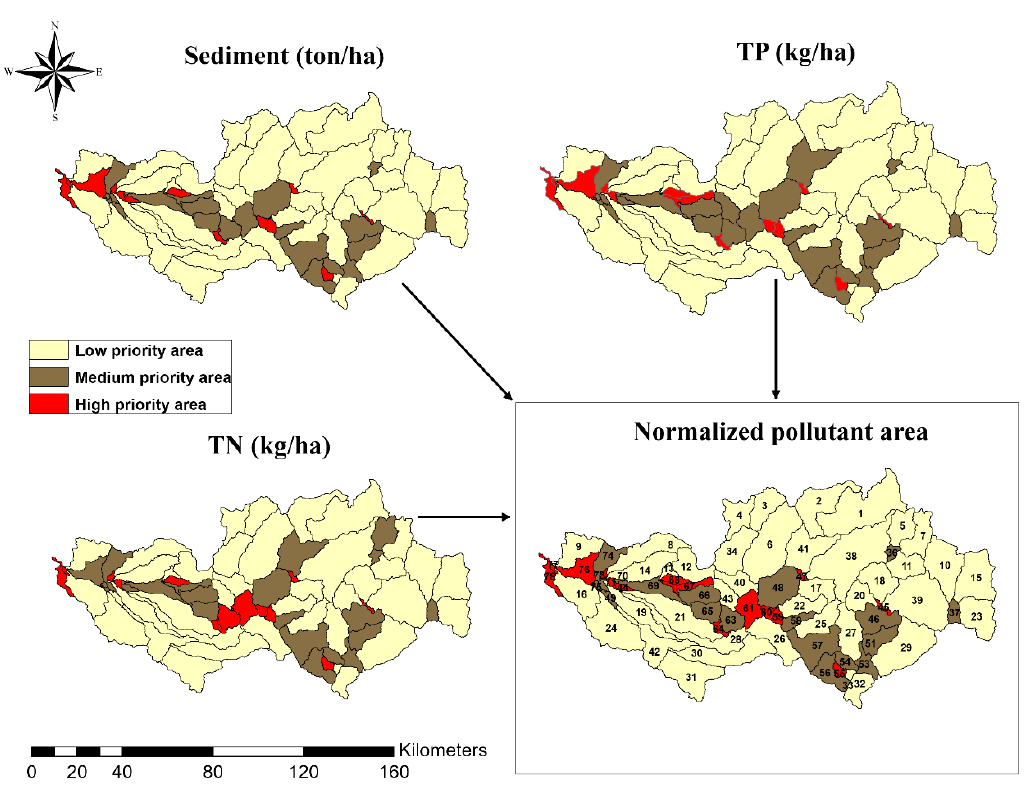
Figure 5. The identified critical hot spots (CHSs) using the LII method.